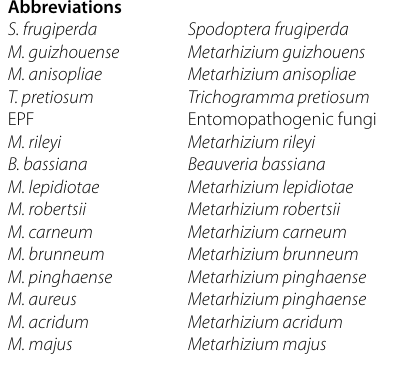
LC 50 represents the concentration required to kill 50% of the individuals in the insect population tested. “–” indicates that the final mortality rate of S. frugiperda larvae is less than 50%, and LC 50 cannot be estimated